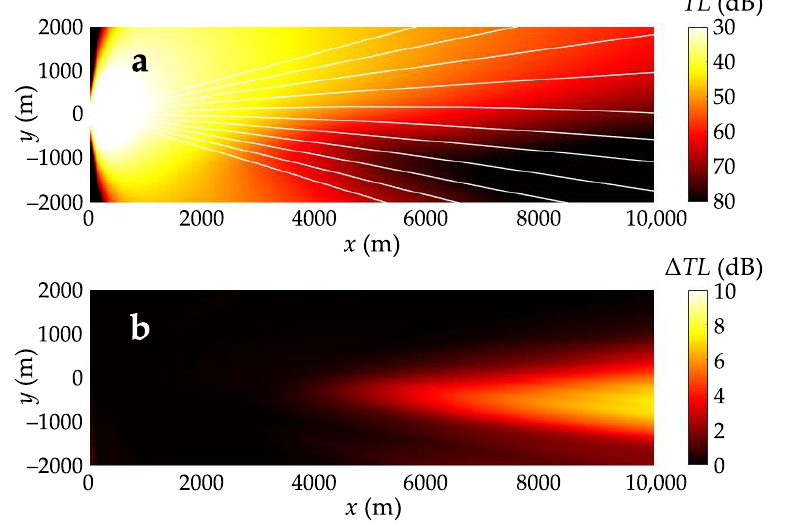
Figure 7. ( a ) Contours in dB of the depth-averaged transmission loss TL in the horizontal plane at 55 Hz in the selected region of the Kara Sea (white lines show the modal rays of the first mode); ( b ) the difference between transmission loss ∆ TL obtained by mode parabolic equation solution and N × 2-D approximate solution at 55 Hz.